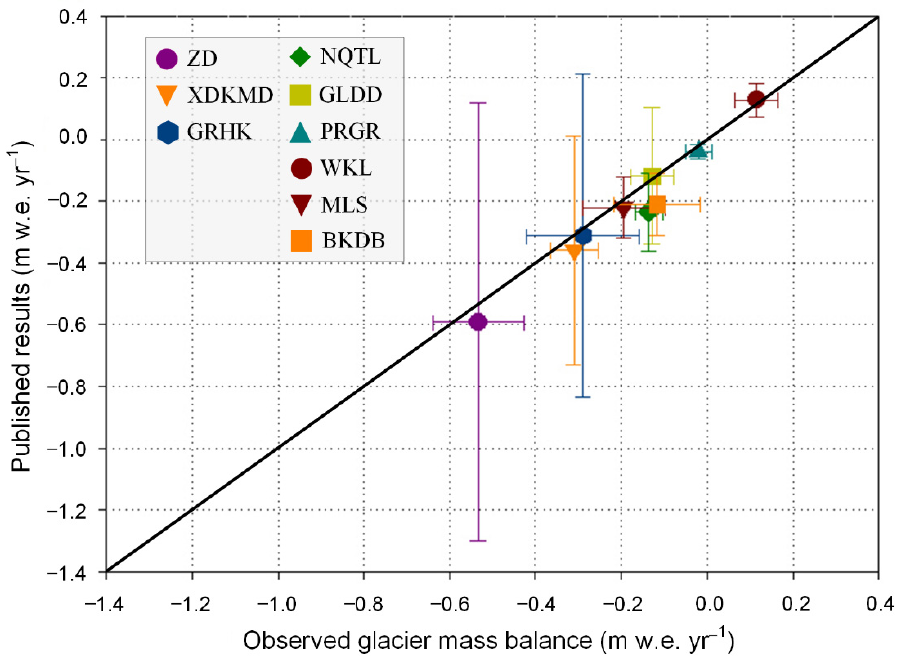
Figure 10. The comparison between our glacier mass change estimations and the field measured results over the individual glaciers of ZD, XDKMD and GRHK, and the published geodetic results over the six study sites of NQTL, GLDD, PRGR, WKL, MLS and BKDB. (ZD: Zhadang Glacier; XDKMD: Xiao Dongkemadi Glacier; GRHK: Gurenhekou Glacier; NQTL: Nainqentanglha Mts.; GLDD: Geladandong Mts.; PRGR: Puruogangri Ice Field; WKL: Western Kunlun Mts.; MLS: Malan Mount; BKDB: Bukadaban peak).